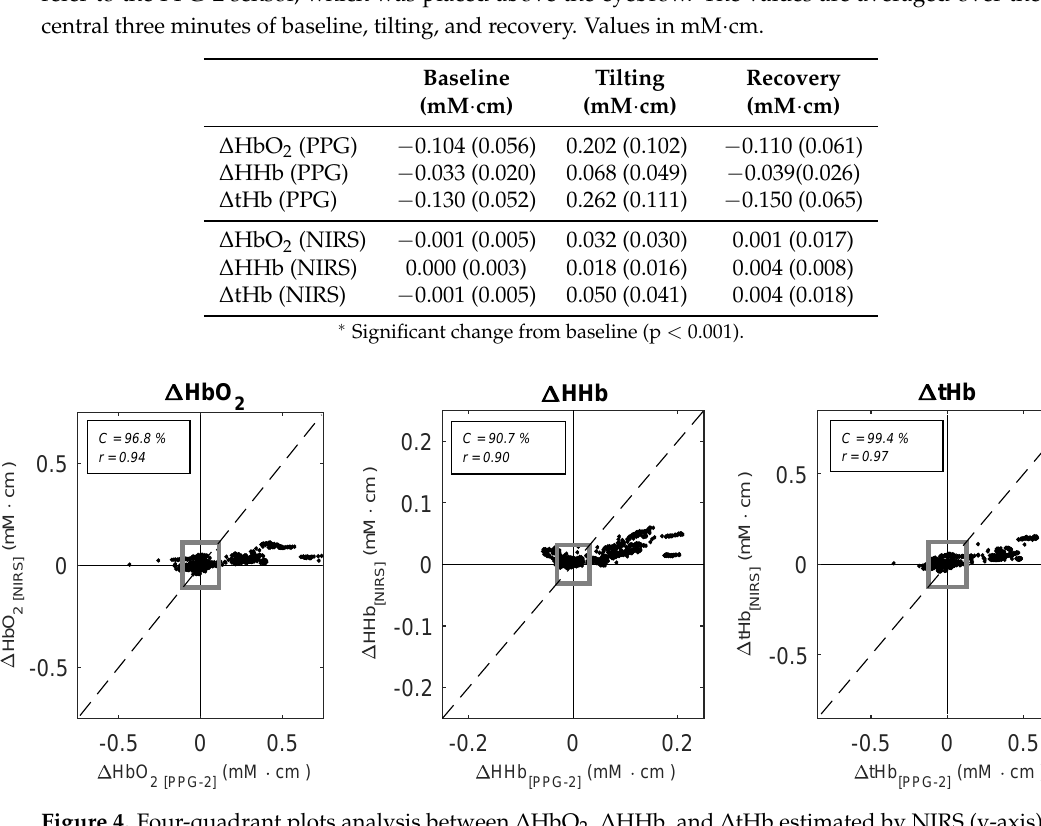
Figure 4. Four-quadrant plots analysis between ∆ HbO 2 , ∆ HHb, and ∆ tHb estimated by NIRS (y-axis) and the PPG-2 sensor (x-axis) during the tilting protocol. Dotted lines represent the line of identity. A total number of n = 100 pair points for each subject were used for the plots. The grey square indicates the 15% exclusion